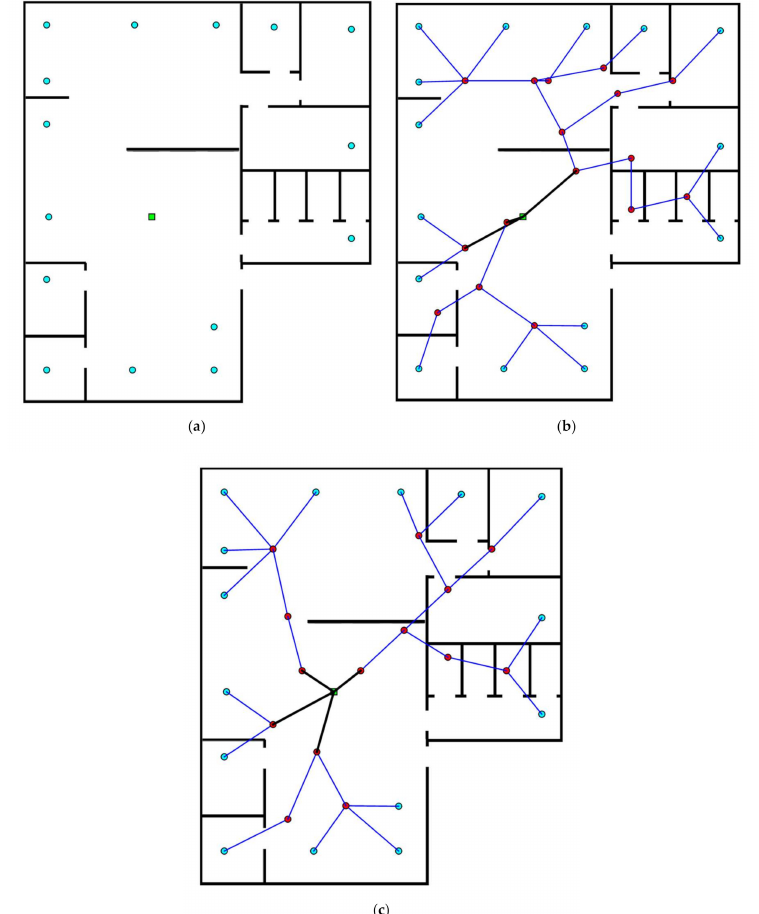
Figure4. Casestudy2: ( a )Initiallayout; ( b )synthesizednetworkusingtheCADtool; and( c )synthesized network using the proposed